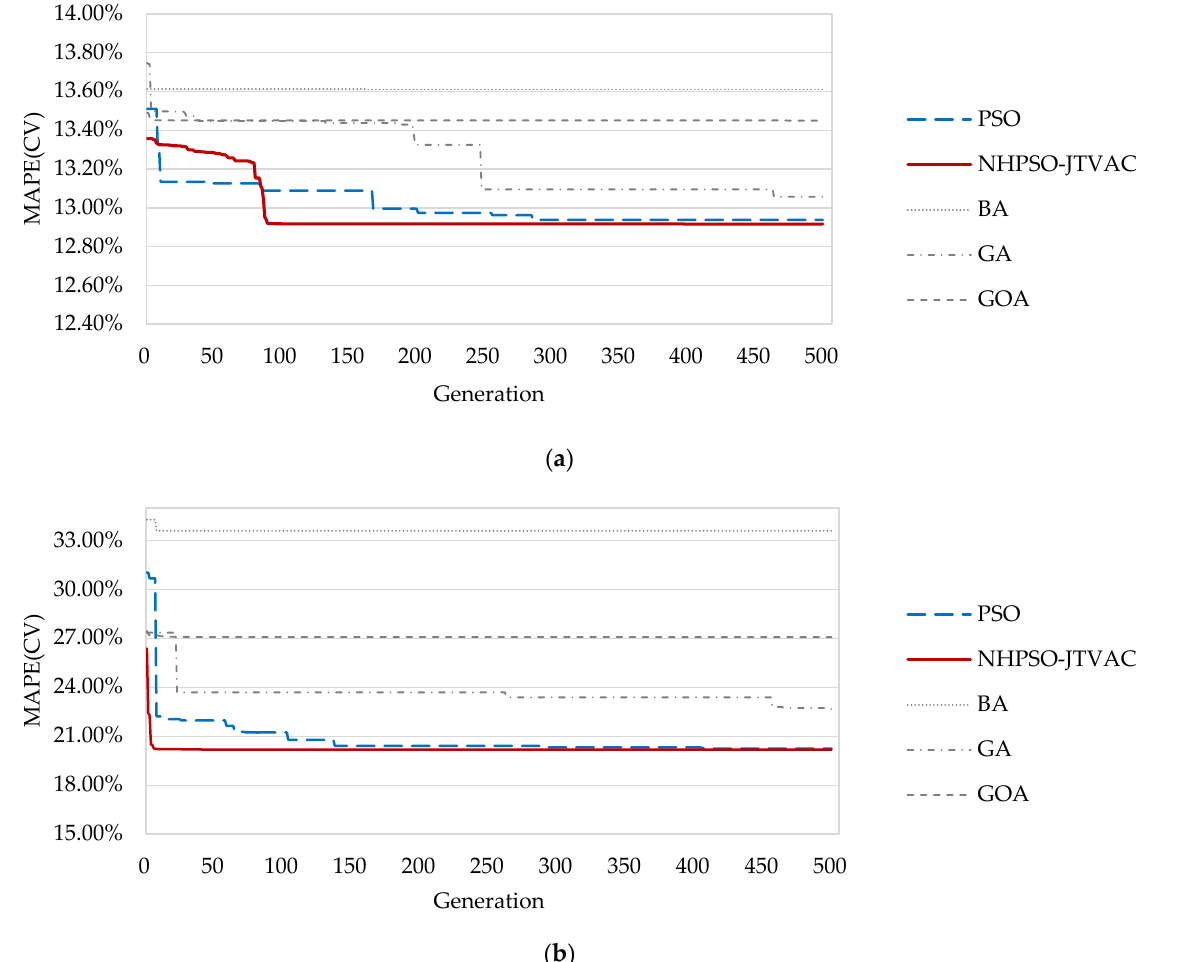
Figure 7. Generation of the optimization models in ( a ) block assembly process performance dataset and ( b ) block pre- outfitting process performance dataset.